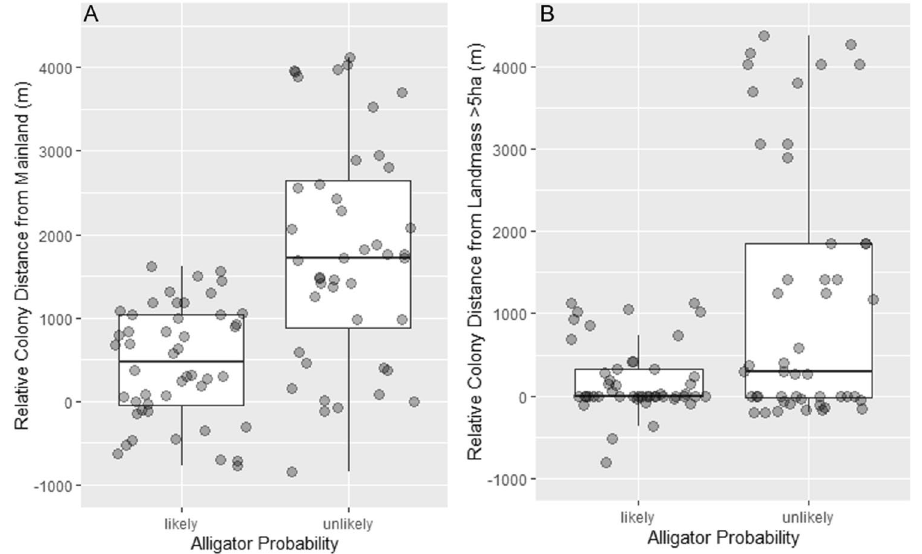
Figure 2. Colony island distance relative to control islands (meters) from ( A ) the mainland and from ( B ) landmasses > 5 ha, for areas with alligator probability of occurrence likely and unlikely. Please note that the distance represented in this figure is the relative distance of colony islands. Relative distance is the difference in distance between colony islands and control islands. For boxes, central line shows the median and boxes include all values within the 0.25 and 0.75 quantiles. Whiskers indicate range excluding